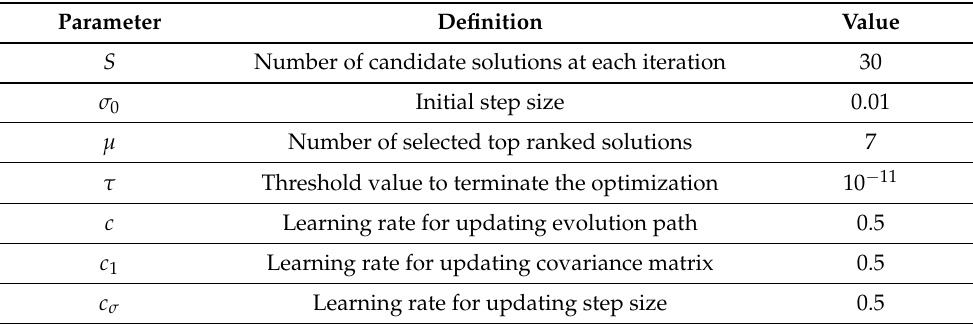
Table 1. The key parameters of covariance matrix adaptation evolution strategy (CMAES) used in this